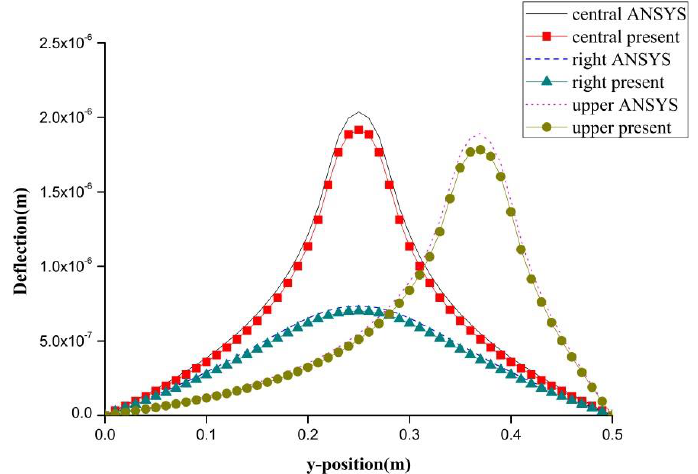
Figure 10. Deflection along the vertical line ( x = 0.25 m) of the composite laminate plate induced by a PZT actuator at three different locations.